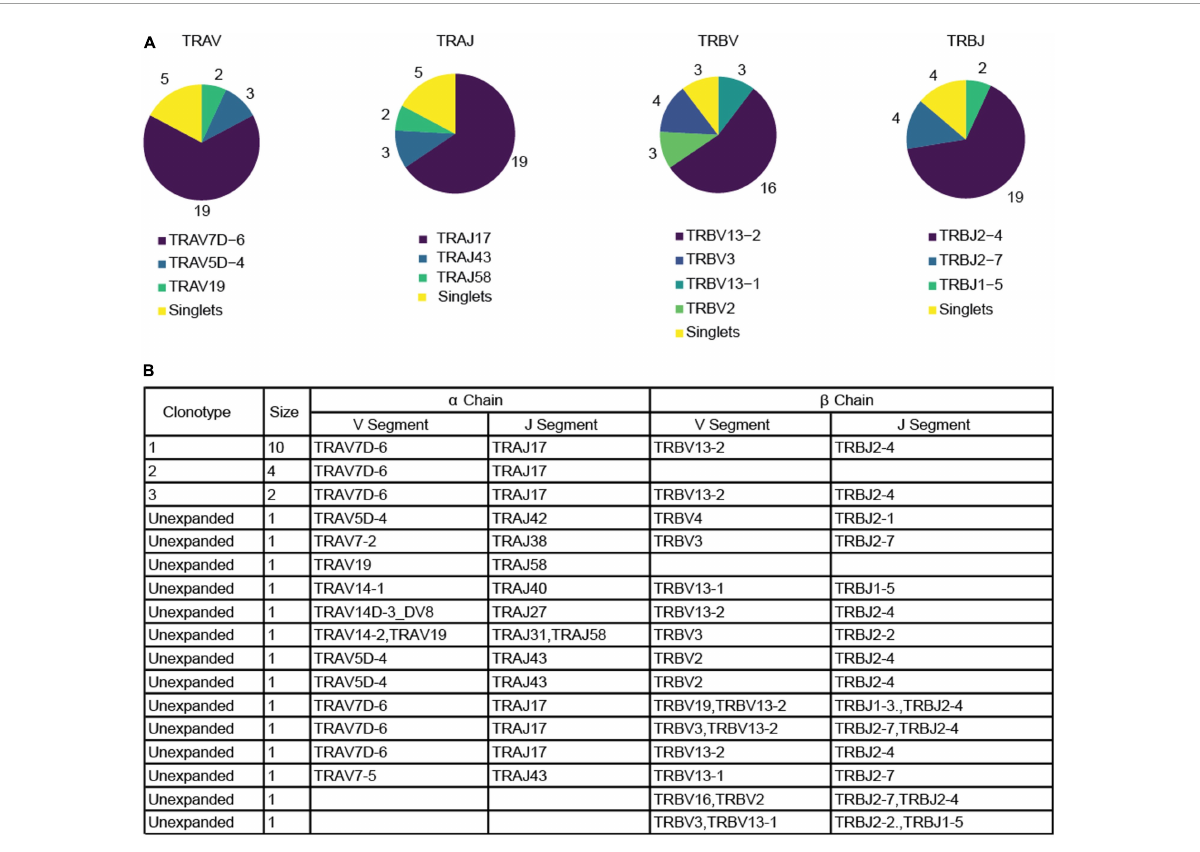
FIGURE2 Productive α and β chain reconstruction for the P6 + cells. (A) Pie charts depicting the frequency of each gene for V and J segment in both productive chains among tetramer + cells. (B) Table listing the reconstructed genes for each productive chain among P6 + cells as well as the size of the clonotype. Blank fields represent cases in which the reconstruction algorithm failed to reconstruct a chain. Two unexpanded cells were excluded because no productive chains were identified. Clonotype calling was based on both productive and non-productive chains.